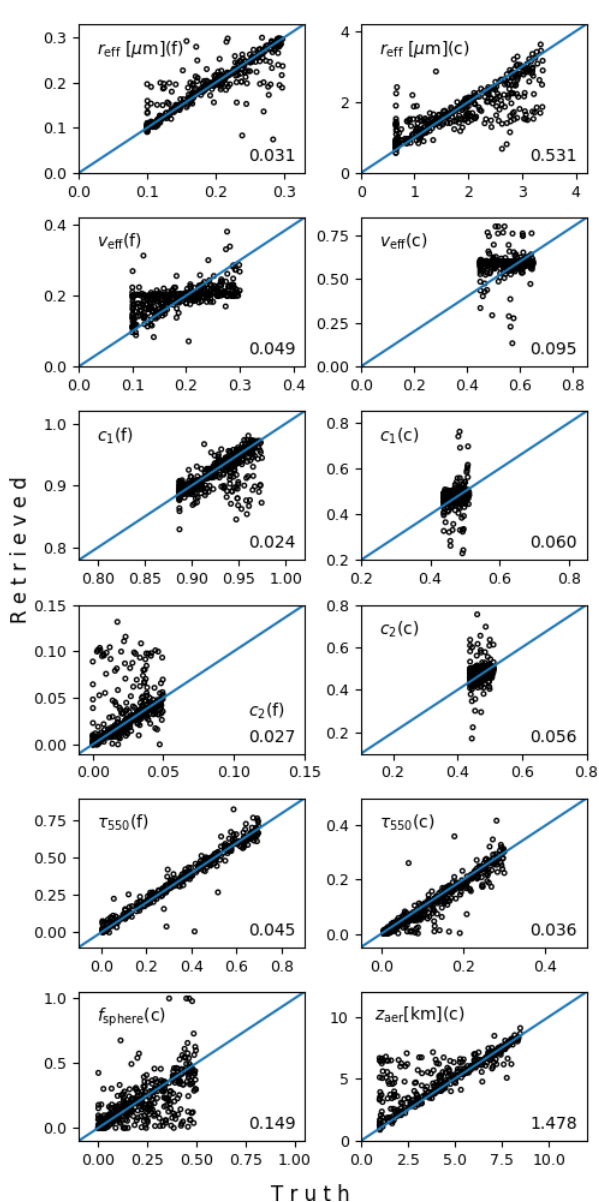
Figure B3. Same as Fig. B2 but for the joint